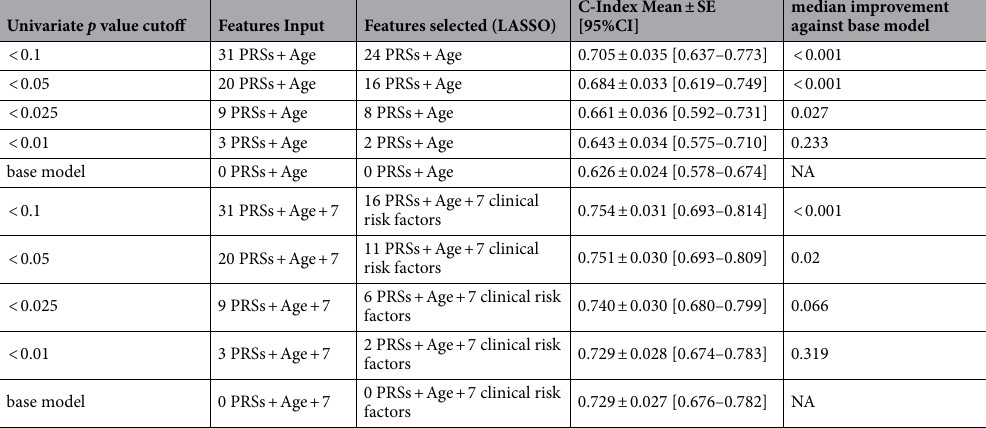
Table 2. Predictive performance of the integrated multivariate Cox proportional-hazard regression model with different entry levels for pathway-specific PRSs included for feature selection by LASSO method. The seven clinical risk factors include AFib, BMI, CAD, diabetes, dyslipidemia, hypertension, and